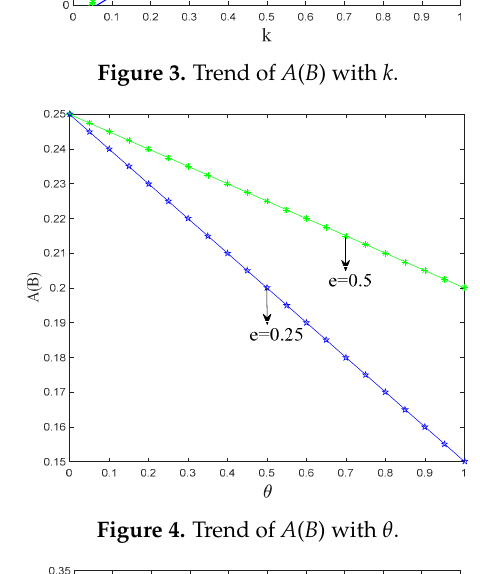
Figure 4. Trend of A ( B ) with θ .